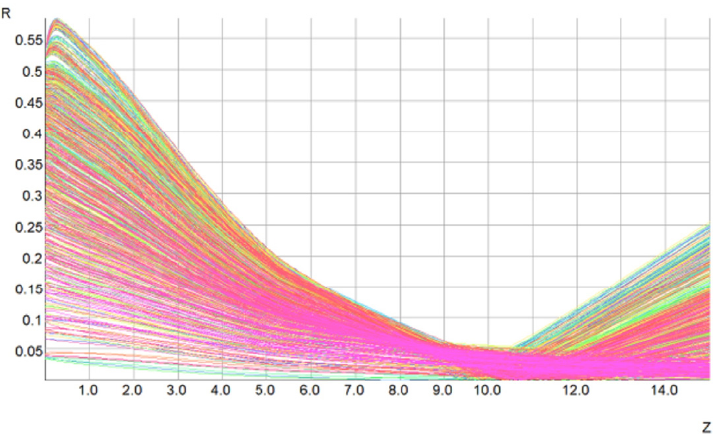
shot of 10 mm, respectively. Figure 1. Building blocks of the G-band TWT.